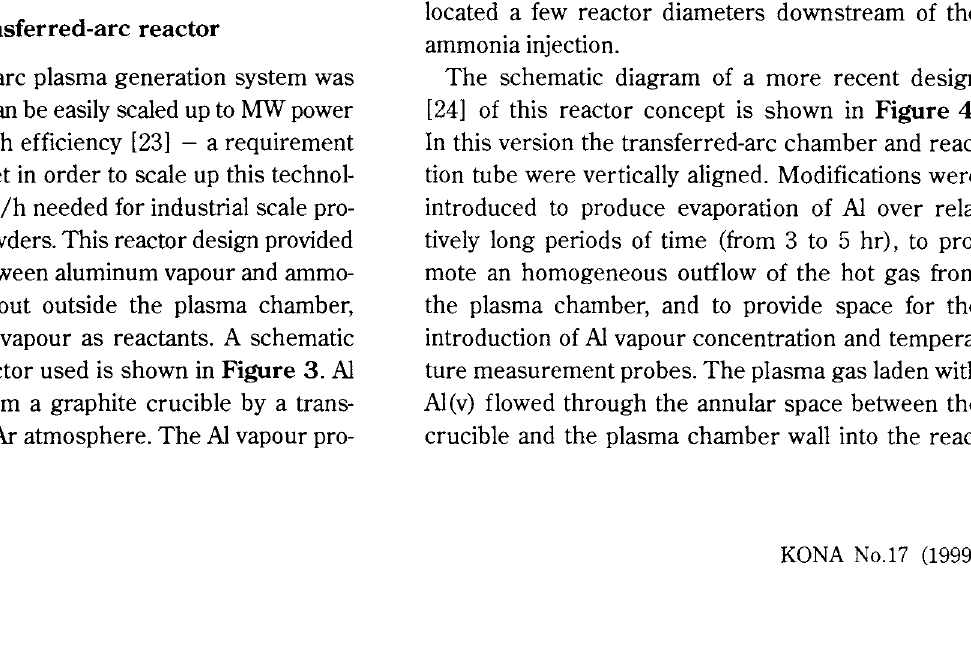
Schematic diagram of the two-stage transferred arc reac tor used by Moura and Munz [23) for the synthesis of AIN ultrafine